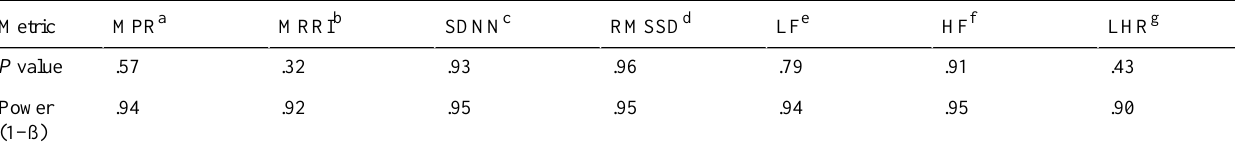
Table 3. Results of primary analysis including all participants (Student t tests).